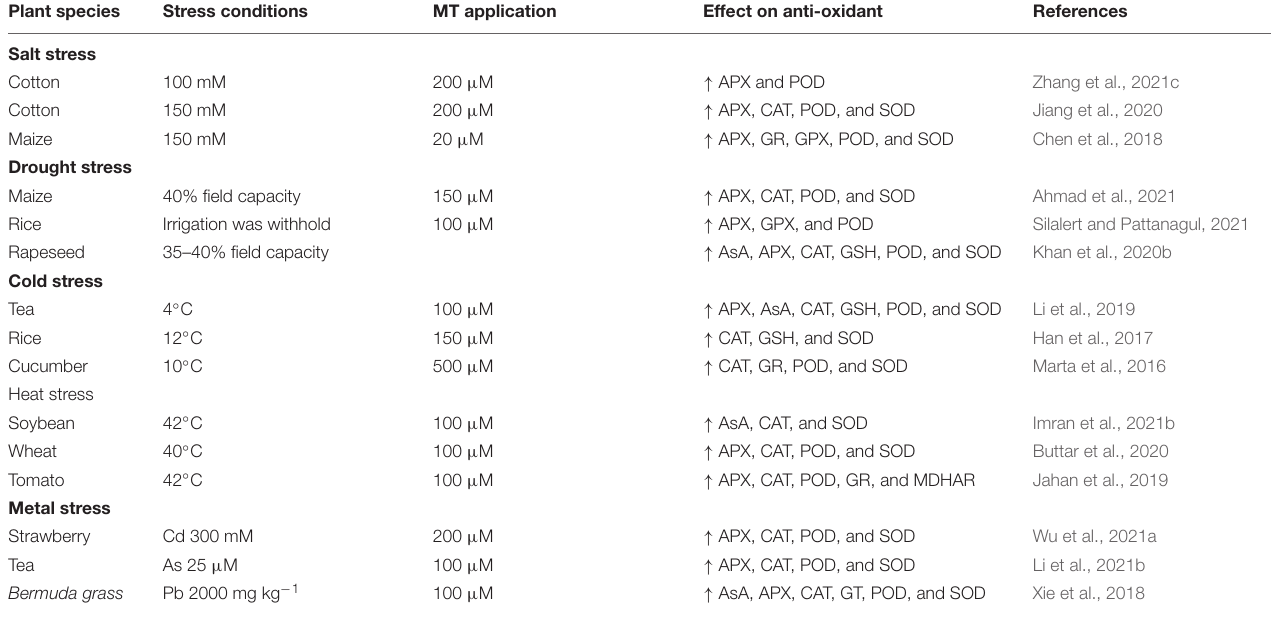
TABLE 6 | Effect of MT application on anti-oxidant defence system under different stress conditions. Plant